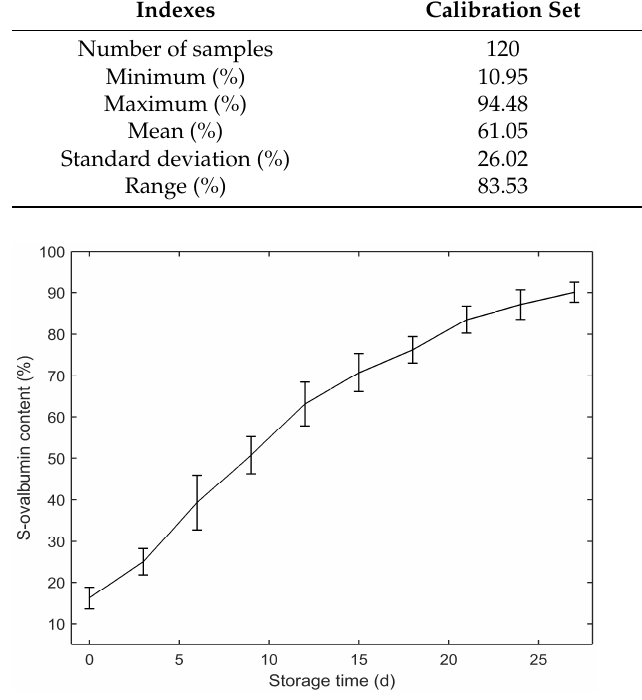
Figure 3. S-ovalbumin content of egg samples at different storage periods.